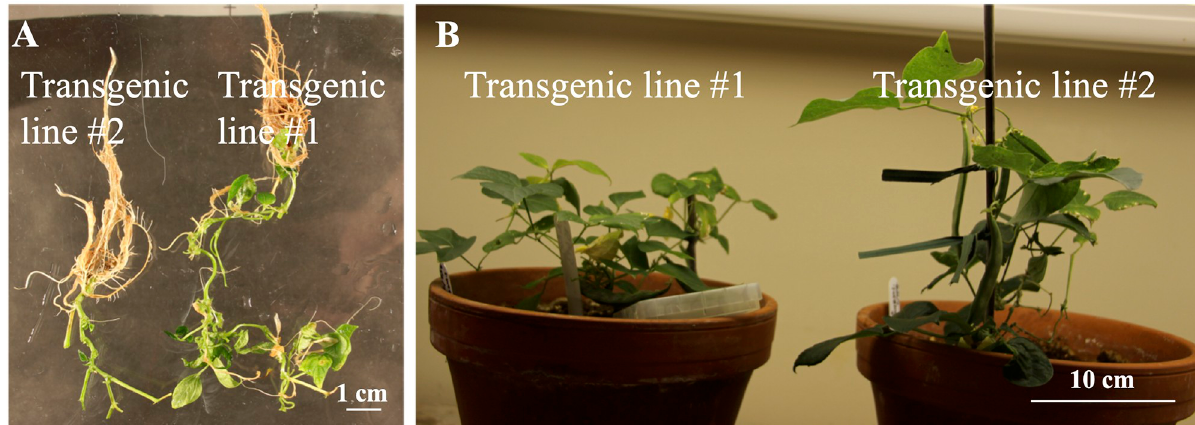
Fig 4. Rooting of T 0 ‘Olathe’ pinto bean and T 1 seed production. (A) Rooting of GS-resistant plants on selection MS. (B) Production of T 1 seeds at 23–25 ˚C under a 16 h photoperiod of 55 μ mol m -2 s -1 .